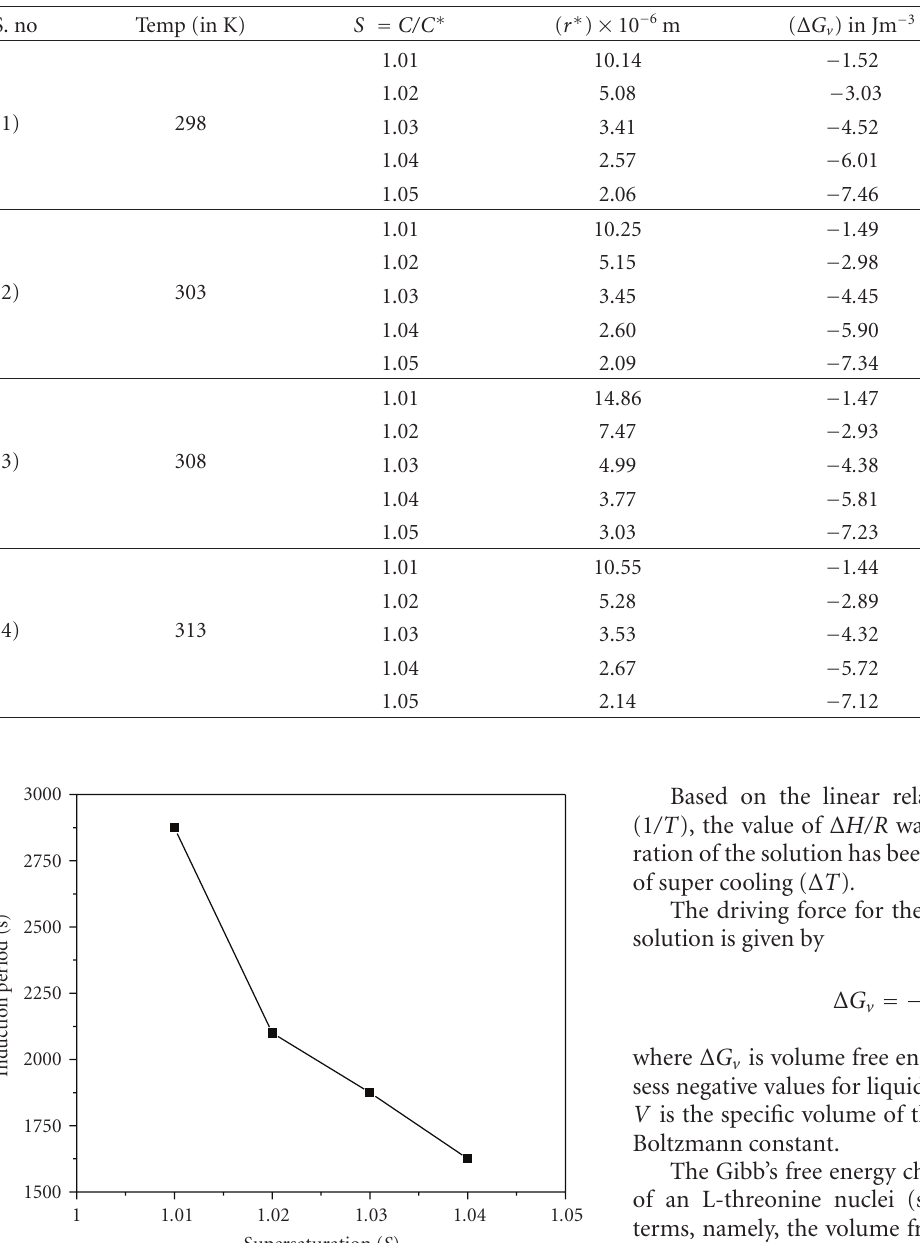
Table 1: Critical radius ( r ∗ ), critical free energy ( Δ G ∗ ), volume free energy ( Δ G v ) calculated at various supersaturation values.